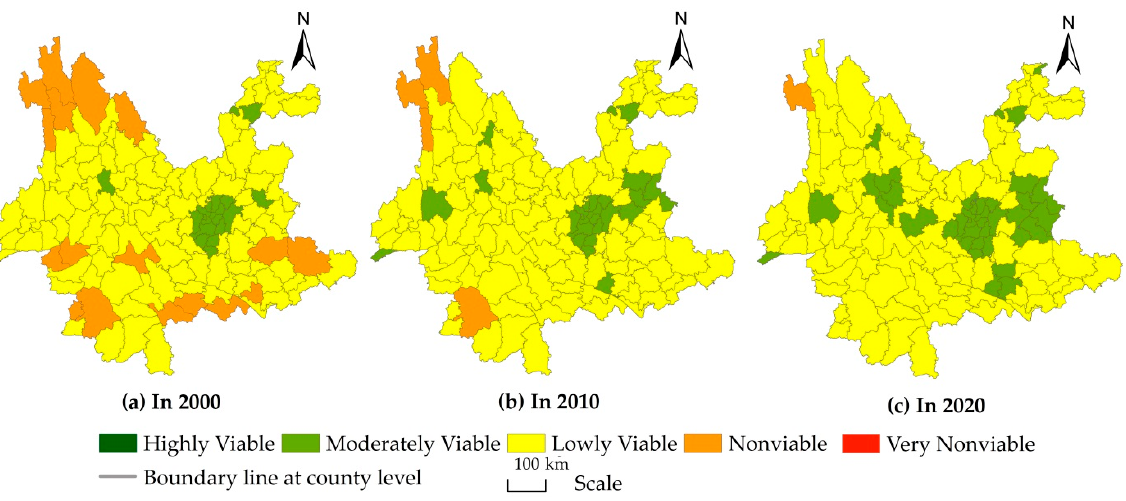
Figure 4. Economic viability evaluation of land use from 2000 to 2020.